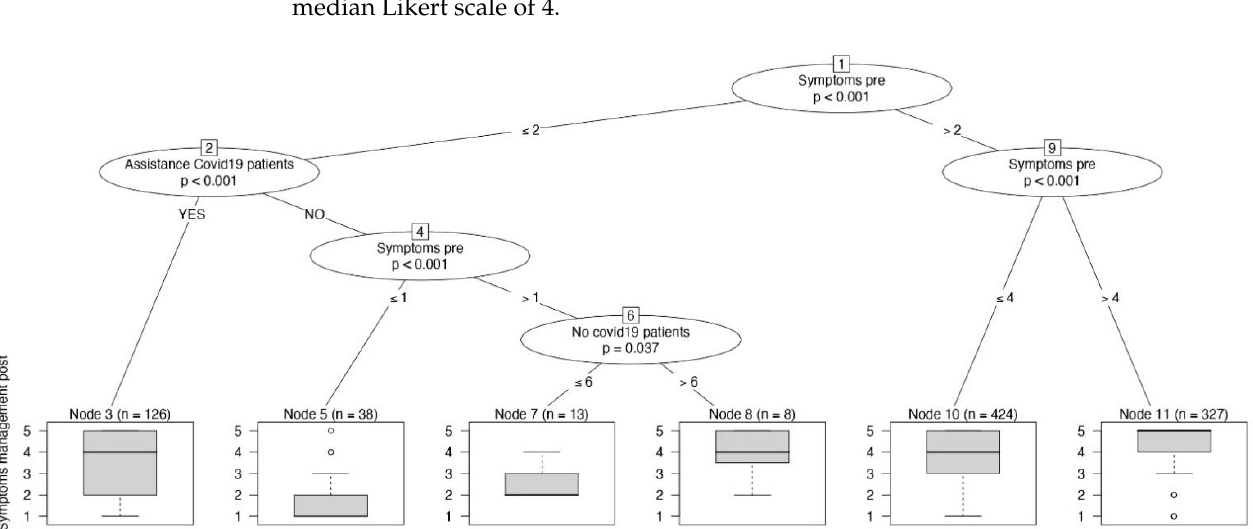
Figure 5. The conditional inference tree with the frequency of nurse–patient relationships as dependent variable, reported at the bottom of the figure as boxplot. RNs’ satisfaction with the care provided remained stable during the pandemic ( p < 0.001; before: median 4, IQR 3–4; during: median 3, IQR 2–4), but younger nurses (aged ≤27 years) tended to judge their care as poor ( p = 0.047), with a median Likert scale of 2 (node 12, Figure 6). Similarly, nurses with less work experience (≤13 years) reported a decreased quality of care ( p = 0.032). RNs who reported high preparedness in terms of education/training showed increased care satisfaction ( p = 0.039), with a median Likert scale of 4 (node 10, Figure 6).